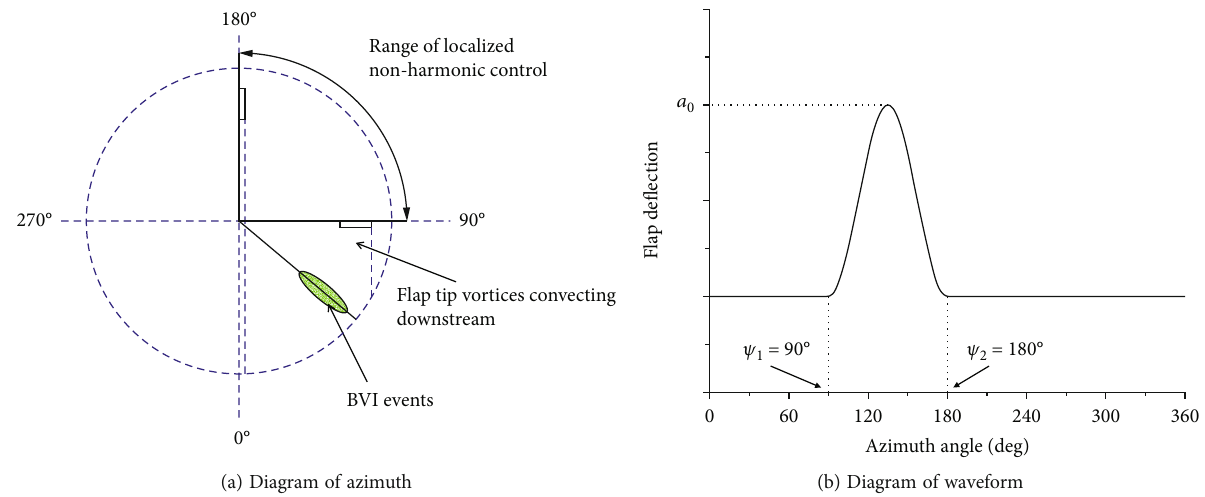
Figure 2: Schematic diagram of the azimuth and waveform of the cosine input in the second quadrant of fl